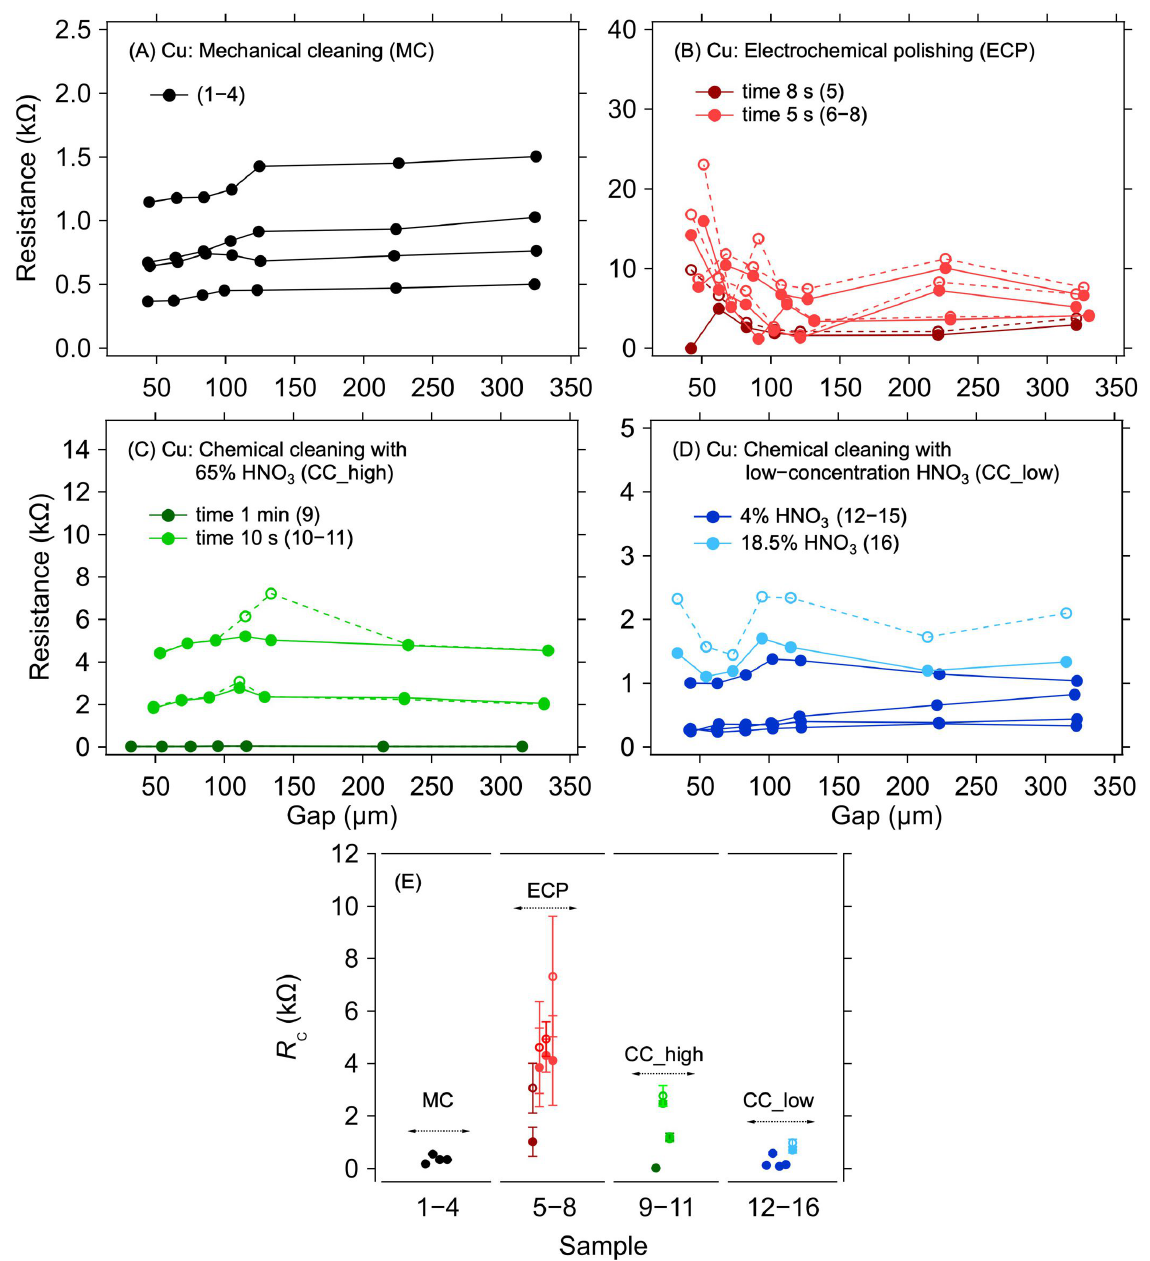
Figure 2. A 1L graphene–Cu electrode contact resistance for different Cu surface treatment methods. Resistance as a function of electrode gap for ( A ) mechanical cleaning, ( B ) electrochemical polishing: dark and light red colours for a polishing time of 8 and 5 s, respectively, ( C ) chemical cleaning in 65% HNO 3 : dark and light green colours for a cleaning time of 1 min and 10 s, respectively, and ( D ) chemical cleaning in low-concentration HNO 3 : dark and light blue colours for 4% and 18.5% concentration, respectively. The lines are guides for the eye only. ( E ) Contact resistance determined from the measurements shown in panels ( A – D ) with corresponding colours. The error bars in ( E ) reflect one standard deviation of the linear fits for the R C determination. Solid and dashed lines and full and empty circles depict the first and second measurements (labelled as M1 and M2 in Table 1),